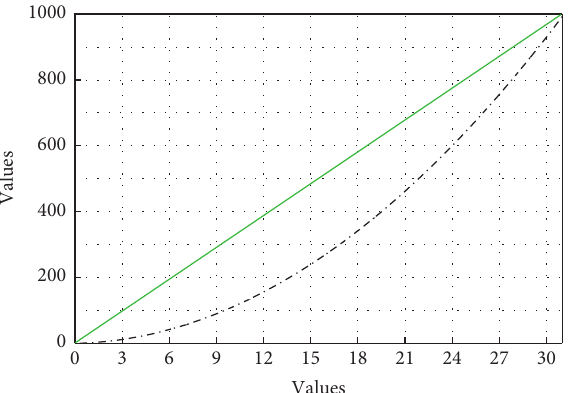
Figure 8: The m AP values of Res RFCN.